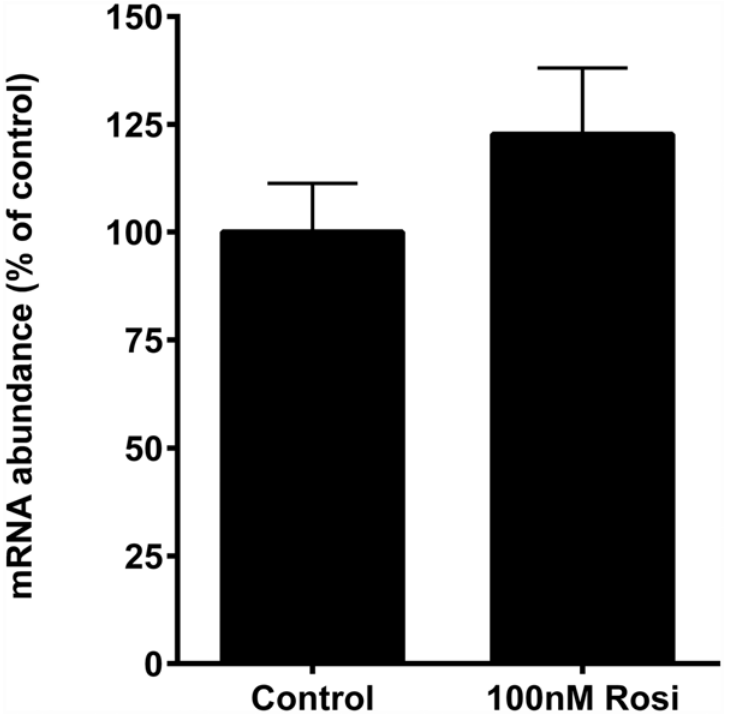
Fig 5. Effect of 24 hr treatment with 100 nM PPAR γ agonist, rosiglitazone (Rosi), on mRNA expression levels for synuclein- γ ( Sncg ) in murine primary dorsal root ganglia neurons. Values are means +/- SEM, n = 17/treatment. Data are from four independent experiments. Transcript level in vehicle-treated control cells was considered 100%. Raw data is provided in S1 Data.